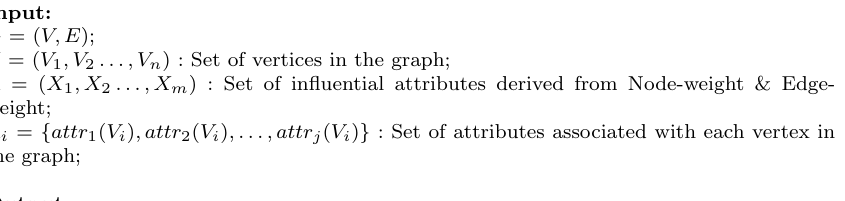
Algorithm 1 Keyword Attribute Index